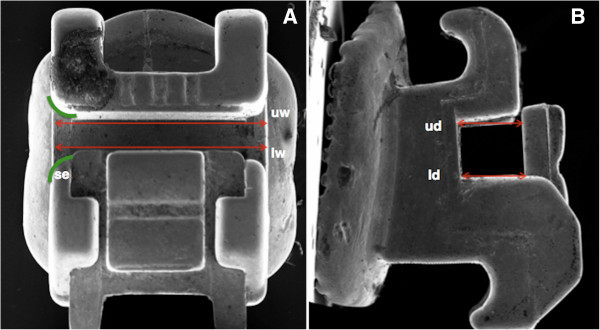
Frontal (A) and lateral (B) views of scanning electron micrograph (SEM) images of Damon bracket. Example of the measurements of slot design performed on Damon SL II bracket: upper width, uw; lower width, lw; upper depth, ud; lower depth, ld; and shape of the slot edges, se.